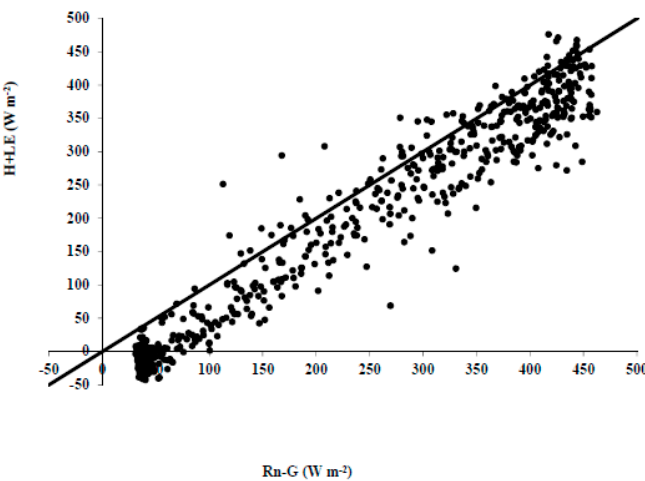
Figure 2. A regression analysis between turbulent energy fluxes (H + LE) from the eddy correlation system and available energy (Rn − G) over a drip-irrigated olive orchard. The solid line represents the 1:1 line. Table 2. Energy balance closure (Cr), Bowen ratio ( β ) and instantaneous ratios of latent (LEB), sensible (HB) and soil (G) heat fluxes to net radiation (Rn) over a drip-irrigated olive orchard at the time of UAV overpasses. Instantaneous ratios of Rn to incoming solar radiation (Rsi) are included. DOY C r